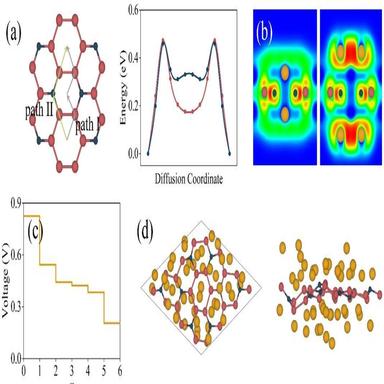
(a) Pathways for Li diffusion on Si3C and the corresponding energy barrier profiles along the diffusion coordinates. (b) Electron localization function maps of (Li4Si3C)2 and (Li6Si3C)2 with one and two adsorption layer. (c) Average voltages of different Li concentrations in (LinSi3C)2 (n = 1–6). (d) Snapshot after equilibration at 300 K for (Li6Si3C)2.